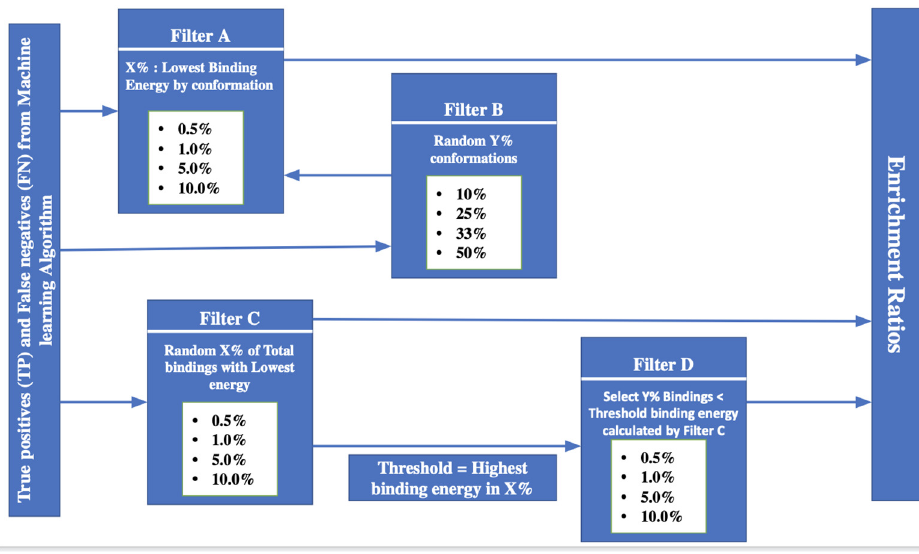
Figure 2. Enrichment ratio Framework.